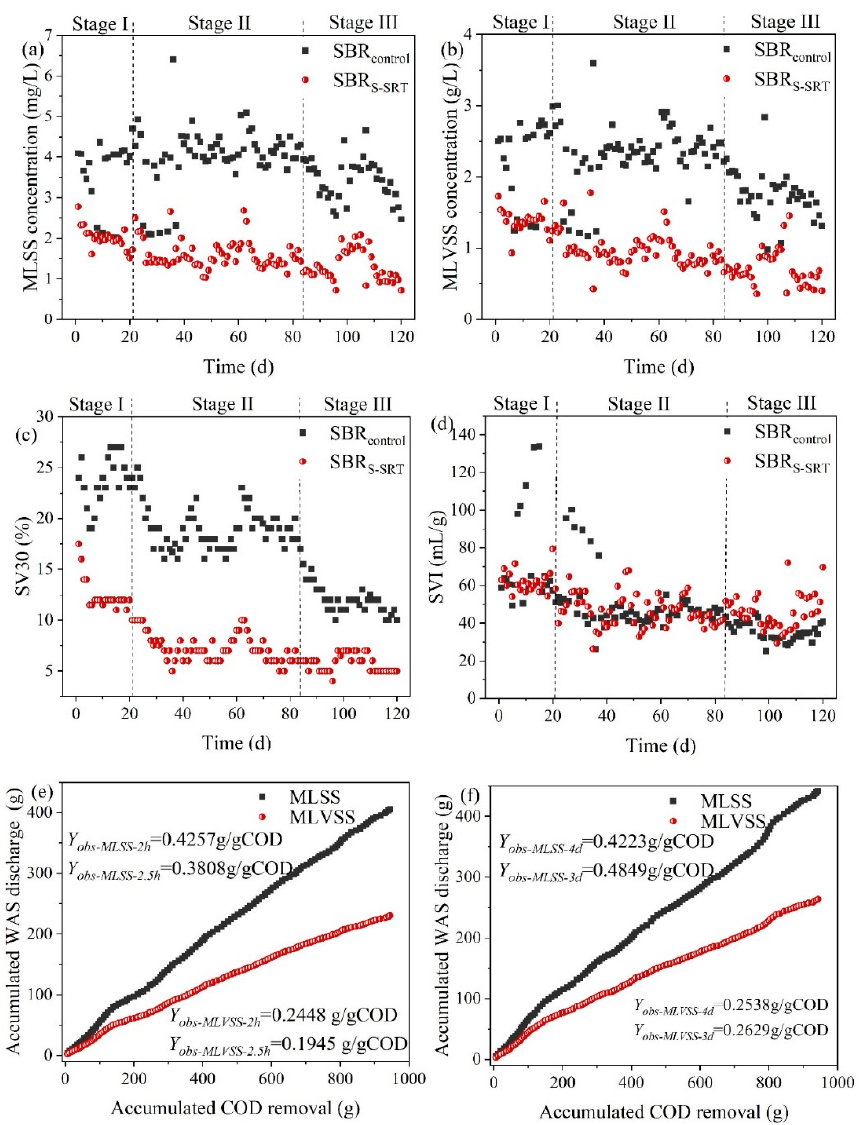
Figure 2. Variations of the sludge ( a ) MLSS and ( b ) MLVSS concentrations, ( c ) SV30 and ( d ) SVI in the two experimental SBRs and the accumulated WAS discharge of ( e ) SBR control and ( f ) SBR S-SRT